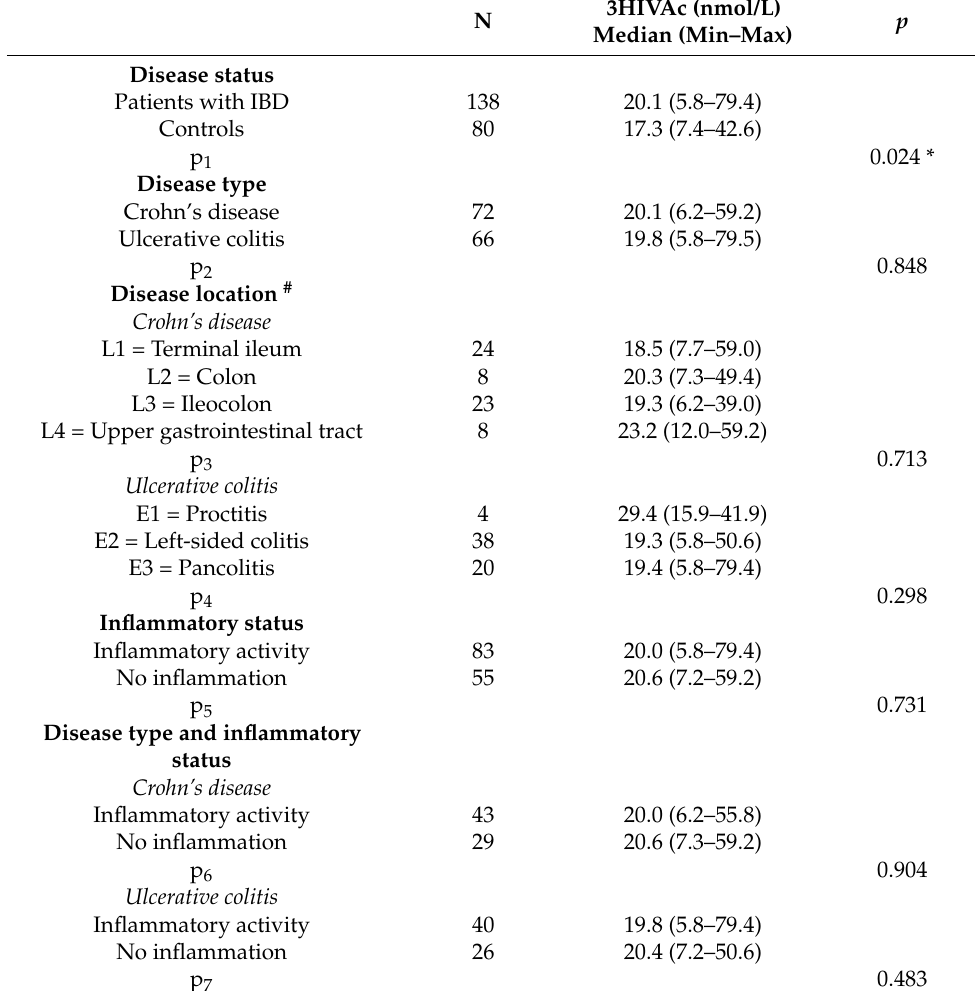
Table 2. Comparison of serum 3HIVAc levels according to disease type and inflammatory